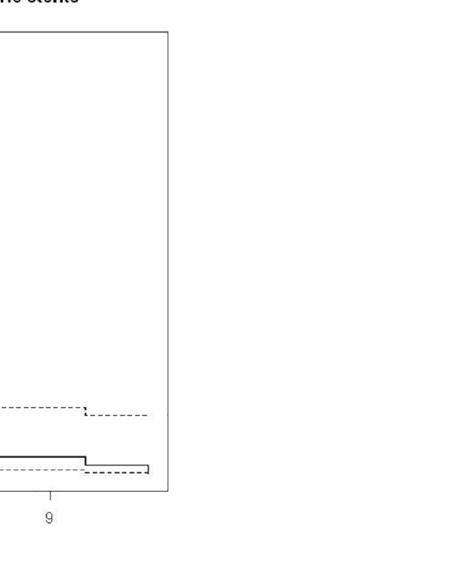
Fig 1. Kaplan-Meier curve of polymeric stents.